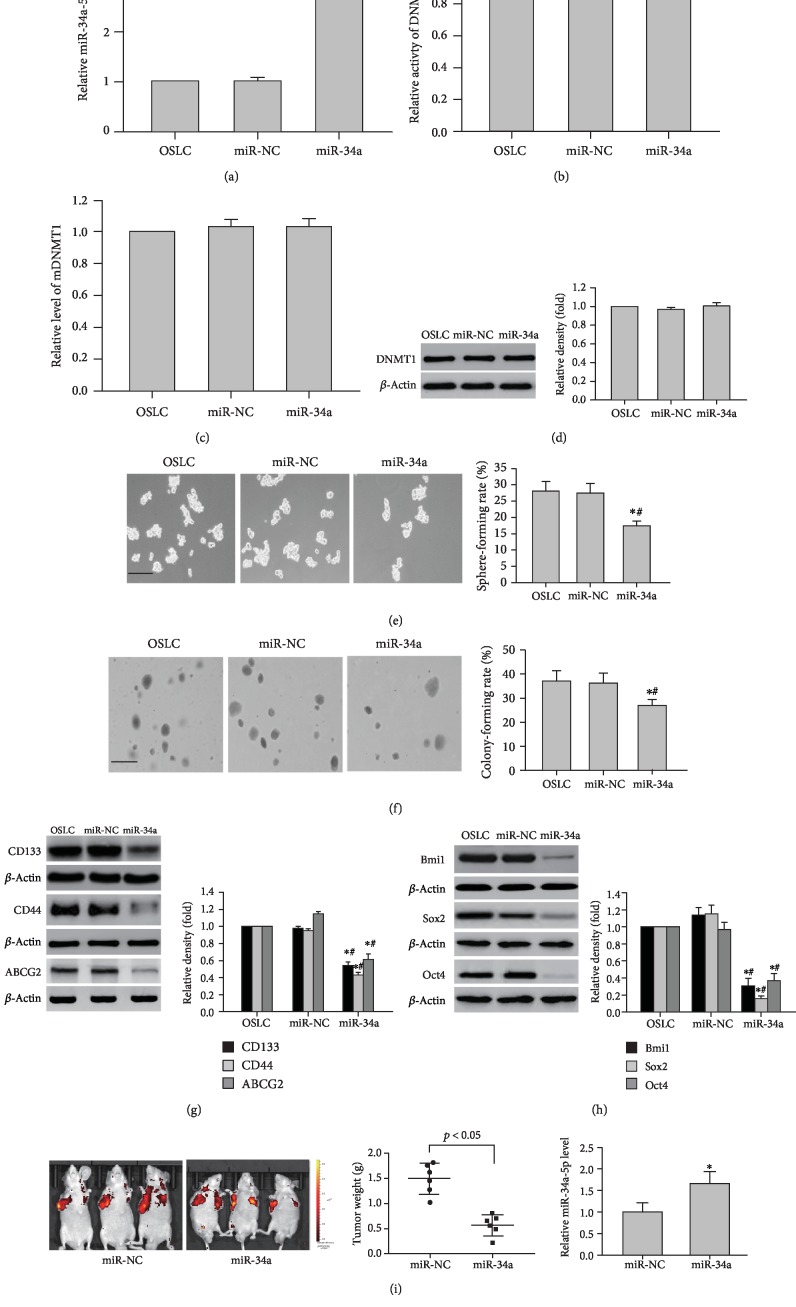
Effects of the miR-34a-5p mimic on the stemness feature in OSLCs. (a) qRT-PCR analyzed the level of miR-34a-5p in OSLCs transfected with miR-NC or miR-34a-5p mimic (miR-34a). (b, c) ELISA and qRT-PCR detected the activities and mRNA levels of DNMT1 in OSLCs transfected with miR-NC or miR-34a. (d) Immunoblot analyzed the expression of DNMT1 in OSLCs transfected with miR-NC or miR-34a, with β-actin serving as a loading control. (e) Representative images of the spheres in OSLCs transfected with miR-34a or with miR-NC and untreated cells serving as the controls (left) (scale bar, 200 μm) and the sphere-forming rate (right). (f) Representative images of the colonies in OSLCs transfected with miR-34a or with miR-NC and untreated cells serving as the controls (left) (scale bar, 200 μm) and the colony-forming rate (right). (g) CD133, CD44, and ABCG2 proteins in OSLCs transfected with miR-34a or miR-NC (left) and their densitometric analysis (right). (h) Bmi1, Sox2, and Oct4 in OSLCs transfected with miR-34a or miR-NC were assessed by qRT-PCR. ∗p < 0.05 (n = 3) vs. OSLCs; #p < 0.05 (n = 3) vs. OSLCs transfected with miR-NC. (i) Images of subcutaneous xenografts of OSLCs (2 × 105) expressing red fluorescent protein (RFP) intratumorally injected with miR-NC or miR-34a (left) and comparison of tumor weight from OSLCs expressing RFP intratumorally injected with miR-NC or miR-34a (middle); and data were obtained from xenograft weighing results from 6 inoculation sites (n = 6). ∗p < 0.05 vs. miR-NC. The expression level of miR-34a-5p of xenograft tumors intratumorally injected with NC or miR-34a (right). ∗p < 0.05 vs. cells injected with miR-NC.